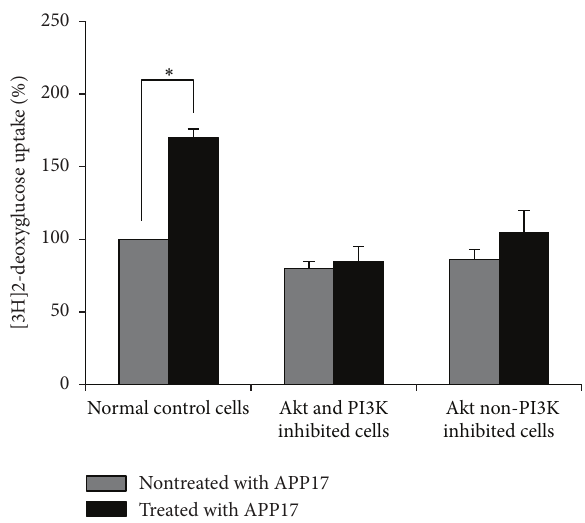
Figure 5: Enhanced insulin-induced glucose transport in PC-12 cells treated with APP17 peptide via PI3K-Akt pathway. Akt and PI3K inhibited cells pretreated with Akt inhibitor 124005; Akt non- PI3K inhibited cells were pretreated with Akt inhibitor